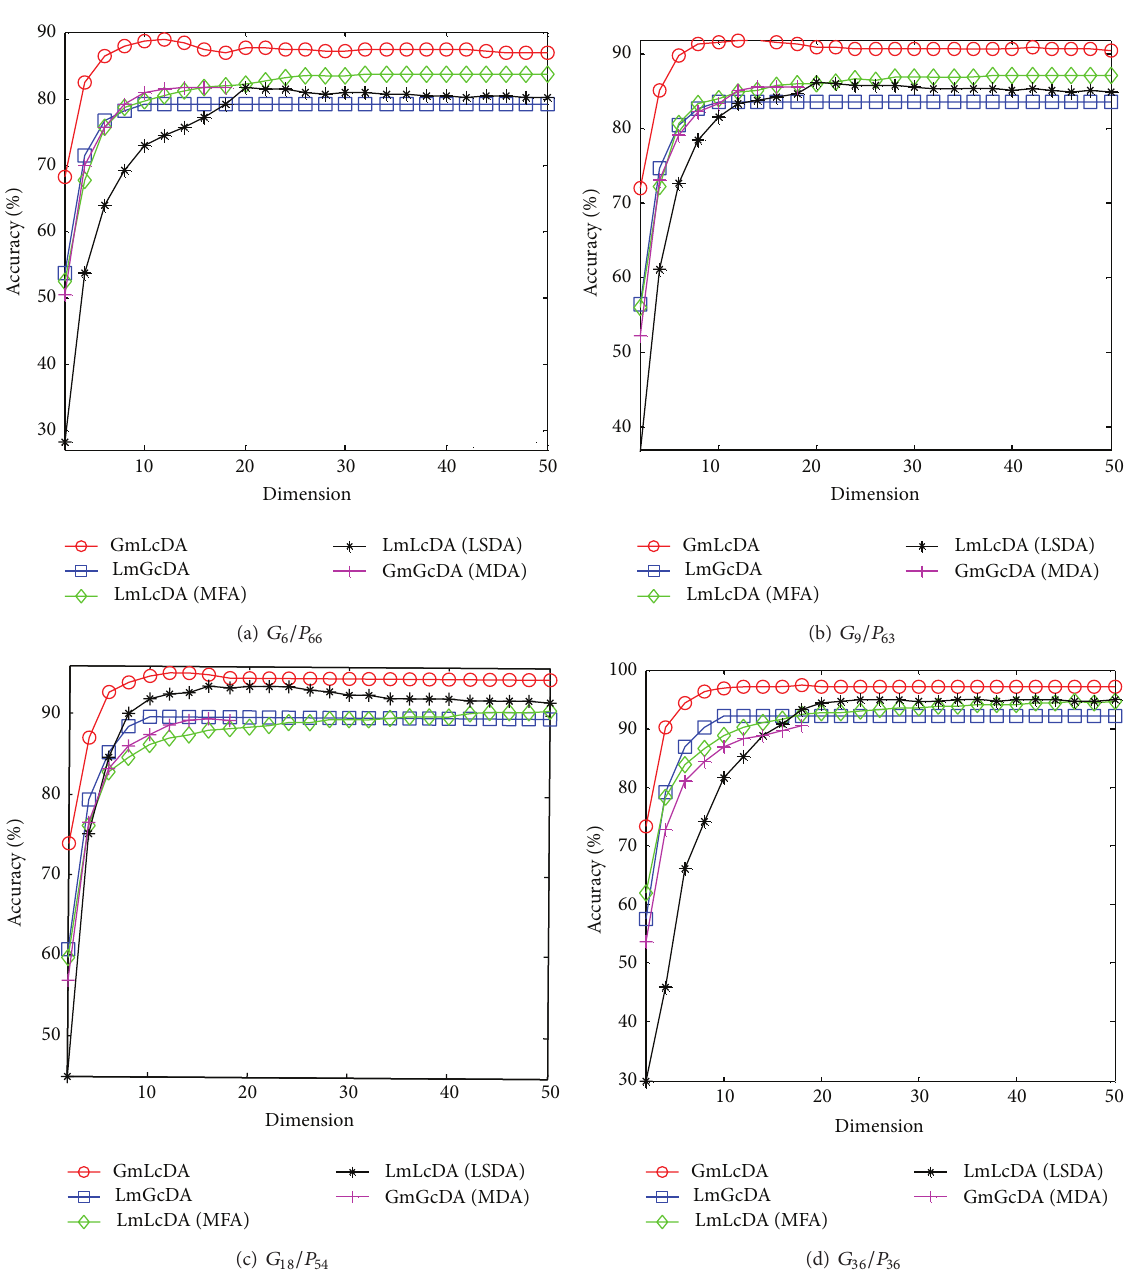
Figure 5: Accuracies with respect to the reduced dimensions on